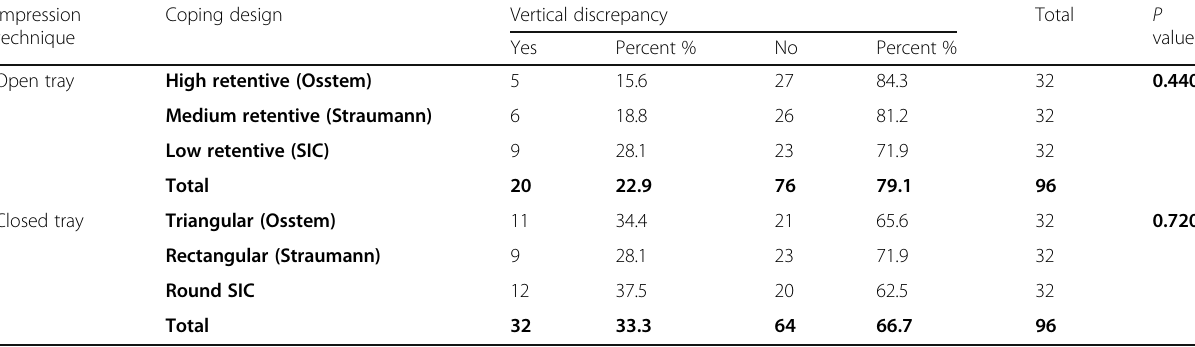
Table 5 Effect of impression coping design on vertical discrepancy Impression technique